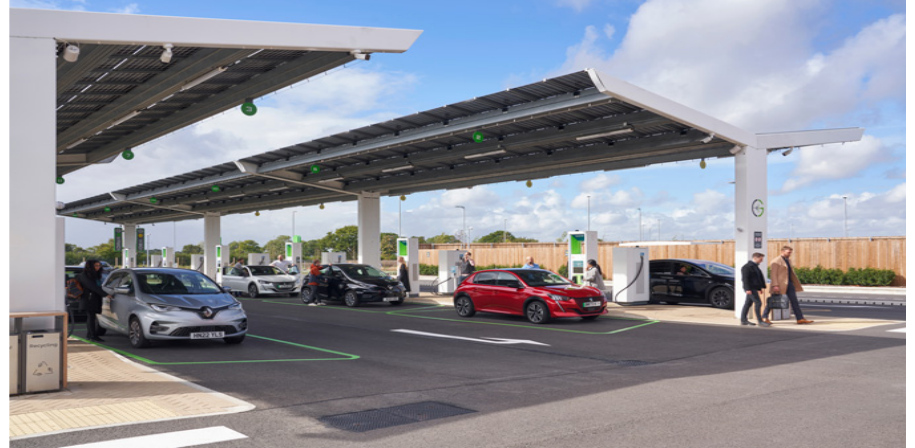
Figure 2. Gridserve Electric Forecourt ® , Essex, UK. Source: Gridserve™ 2022. https://www.gridserve.com/braintree-overview/ (accessed on 9 June 2020).